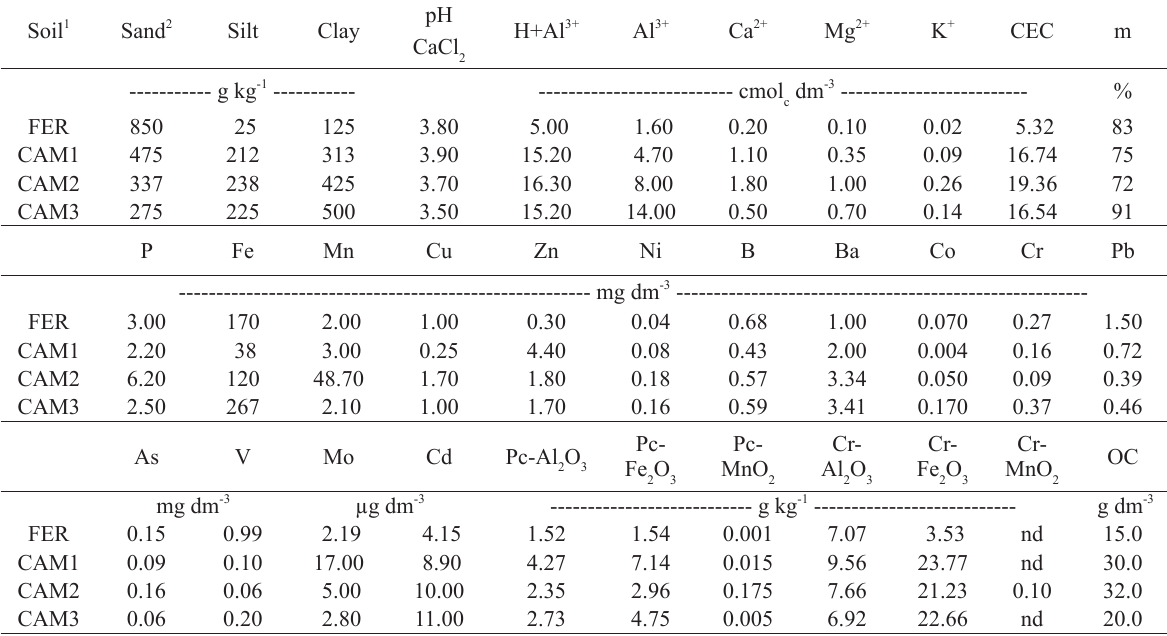
Pre-planting granulometric and chemical analyses of four soils used in the